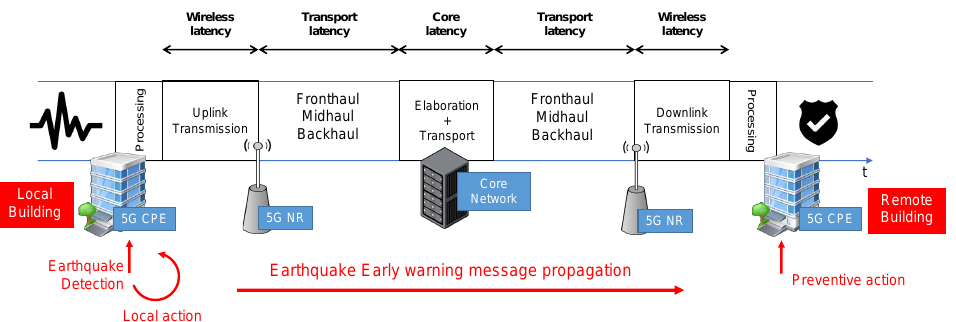
Figure 2. Reference architecture for the 5G-based EEW